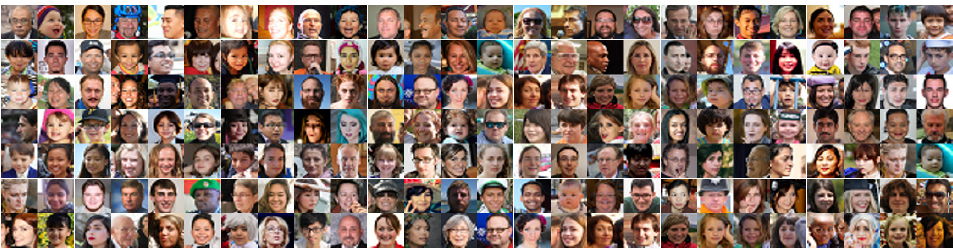
Figure 7. Example of positive faces used for the training.